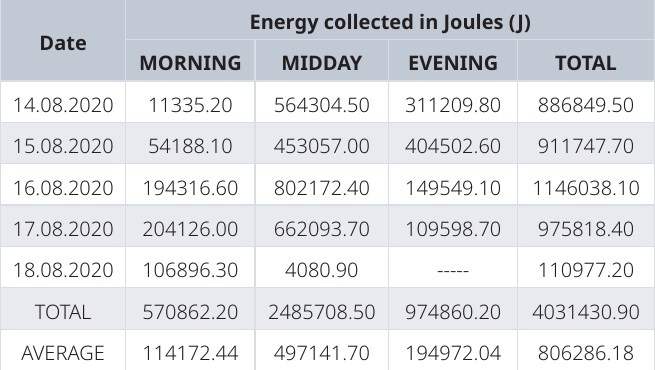
Table 2. Energy collected by tracking solar panel.